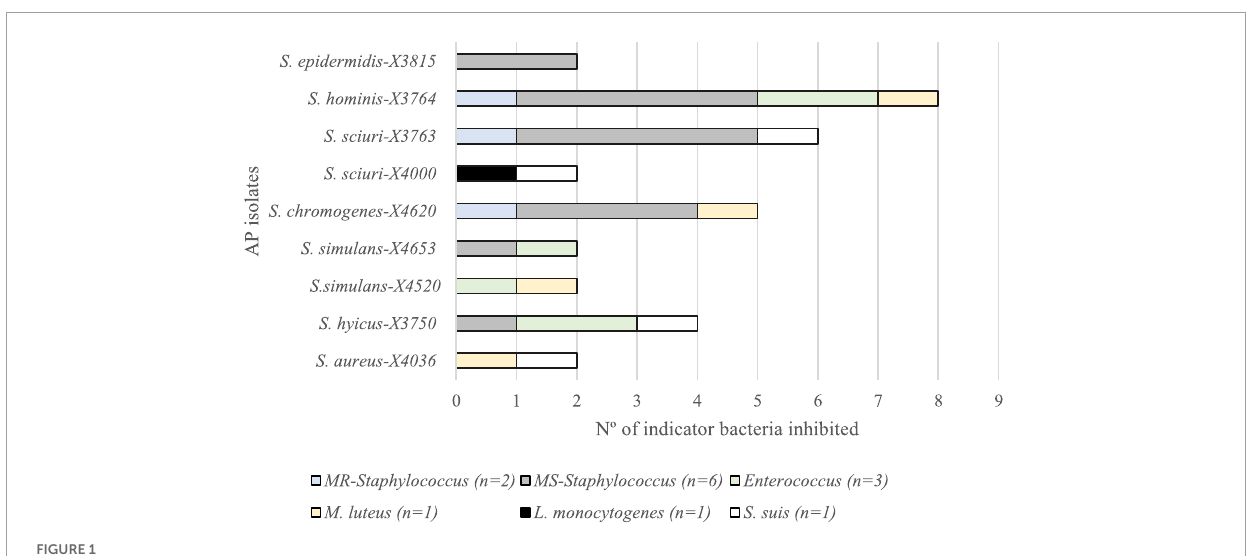
FIGURE1 Antimicrobial activity of the nine antimicrobial producer (AP) isolates against 14 Gram-positive indicator bacteria grouped in six categories ( n , number of isolates of each category), by the spot-on-lawn method.